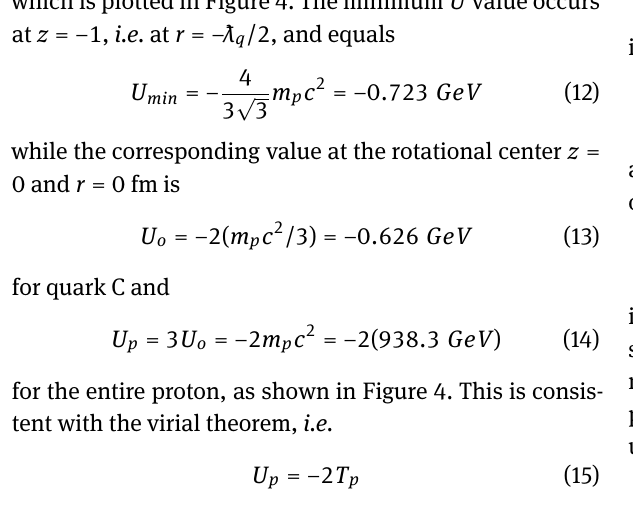
Figure 4: Potential energy in the proton. Gravitational potential energy distribution of quark C (thick line) and of the three quarks to- gether (thick dotted line) in the proton. The negative of the potential . q energy value at r = 0 (the minimum value allowed by the Compton 2 . The latter is wavelength ¯ λ ) is twice the proton rest energy m q p c determined by the kinetic energy, T , of the rotating p